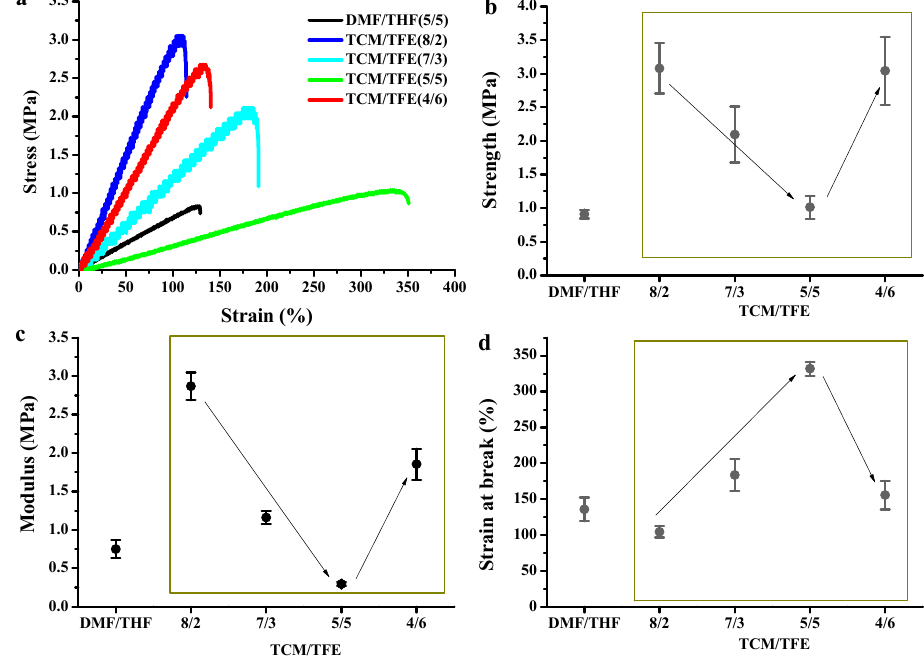
Figure 5. Mechanical properties of TCM/TFE and DMF/THF electrospun nanofibers: ( a ) typical stress-strain curves, ( b ) tensile strength, ( c ) modulus, ( d ) strain at break.